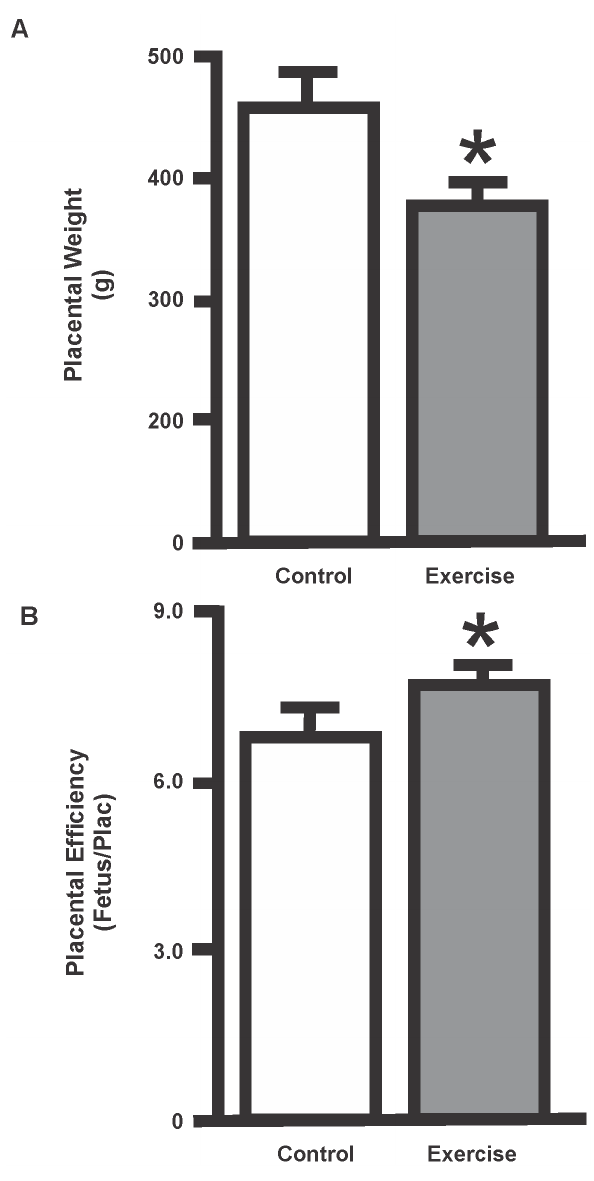
Figure 5. Effects of exercise on placental weight and placental efficiency. A. Placental weight was decreased in the exercise trained compared to the non-exercised. B. The placental efficiency was increased in the exercise group compared to the control group. Data are expressed as mean 6 SEM. (*p , 0.05, as compared with control